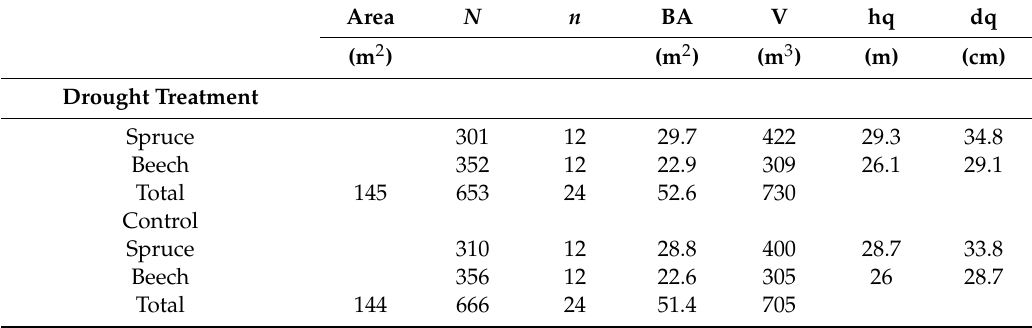
Table 1. Characteristics of the investigated stand where the treatment and control plots were located. ( N : number of trees per ha; n : number of trees with dendrometers; BA: basal area per ha; V: total stem volume per ha; hq: mean height; dq: quadratic mean diameter at 1.3 m breast